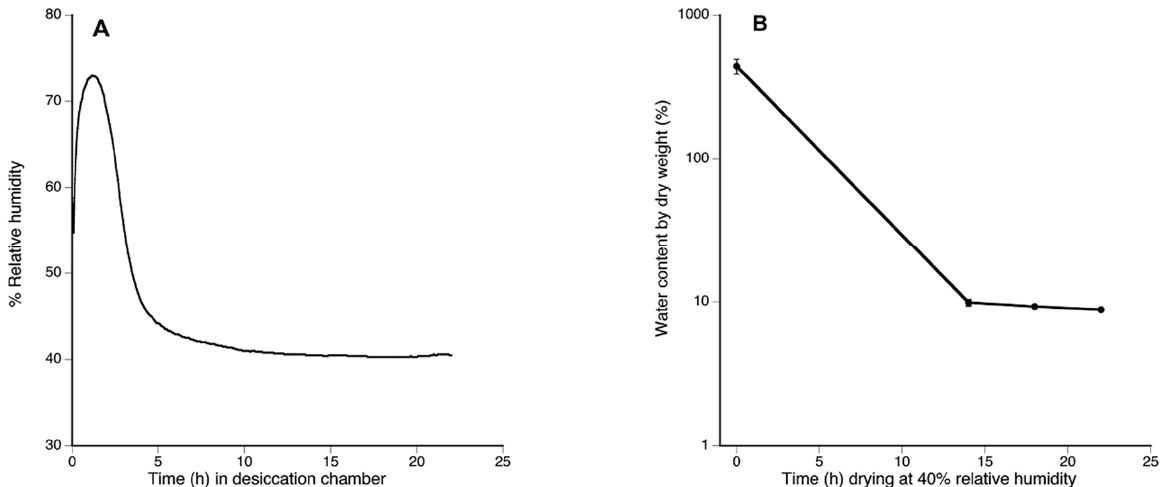
Figure 4. By 14 h in the desiccation chamber Plagiochila porelloides plants reached a desiccated state. ( A ) Relative humidity (RH) inside desiccation chamber during the assay showing RH stabilized in 40% after 10 h (600 min); ( B ) Water plant status showing water content loss during the desiccation assay at 40% RH. The bars indicate standard errors.